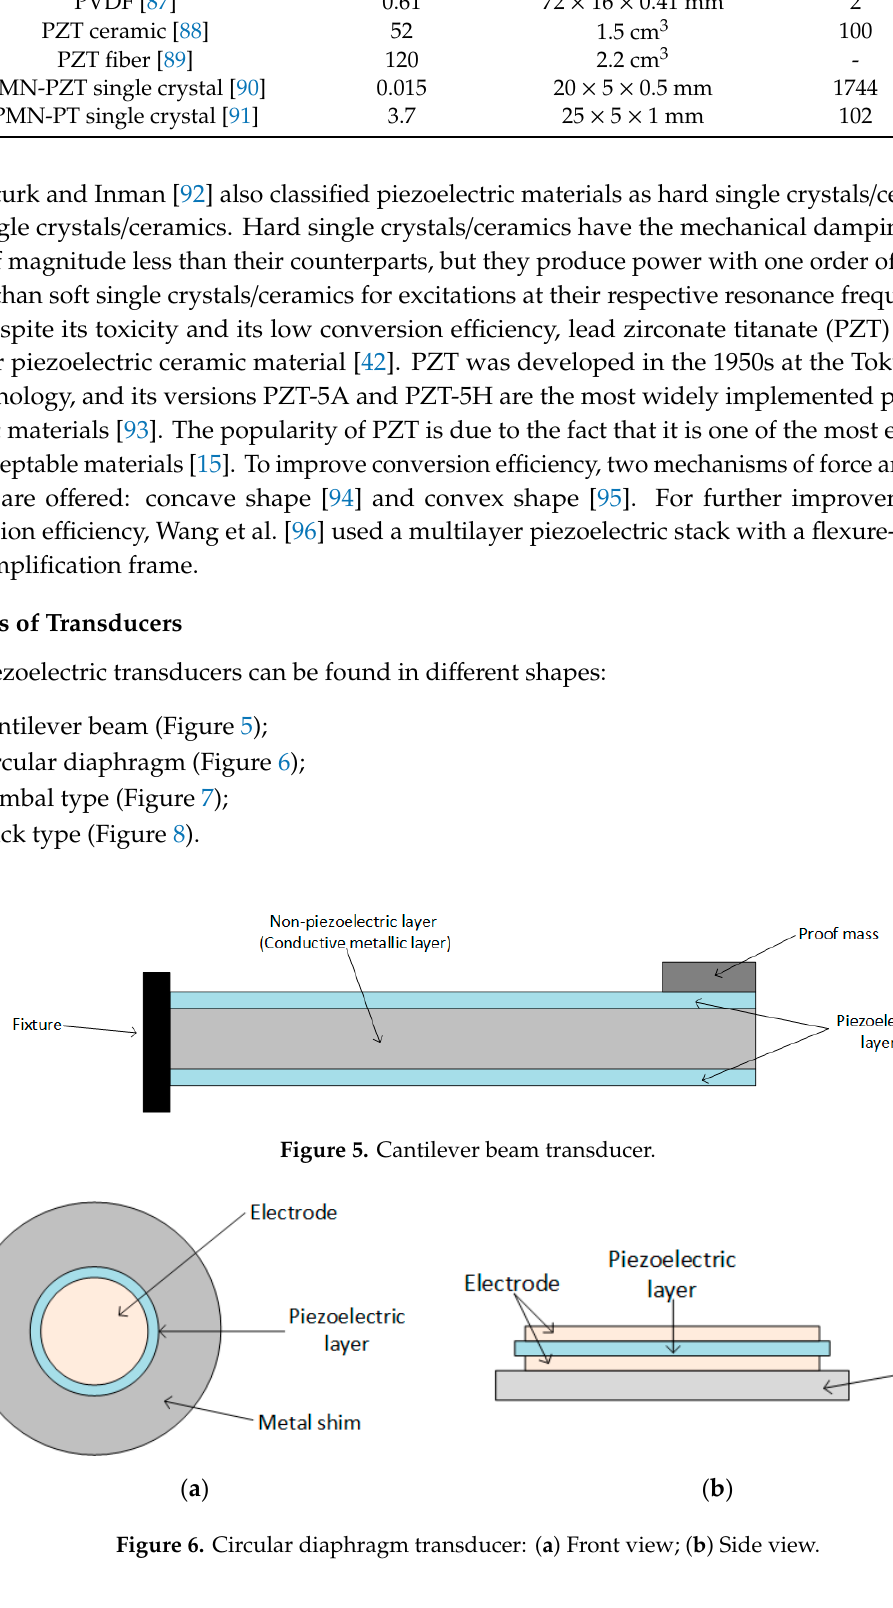
Figure 7. Cymbal transducer.